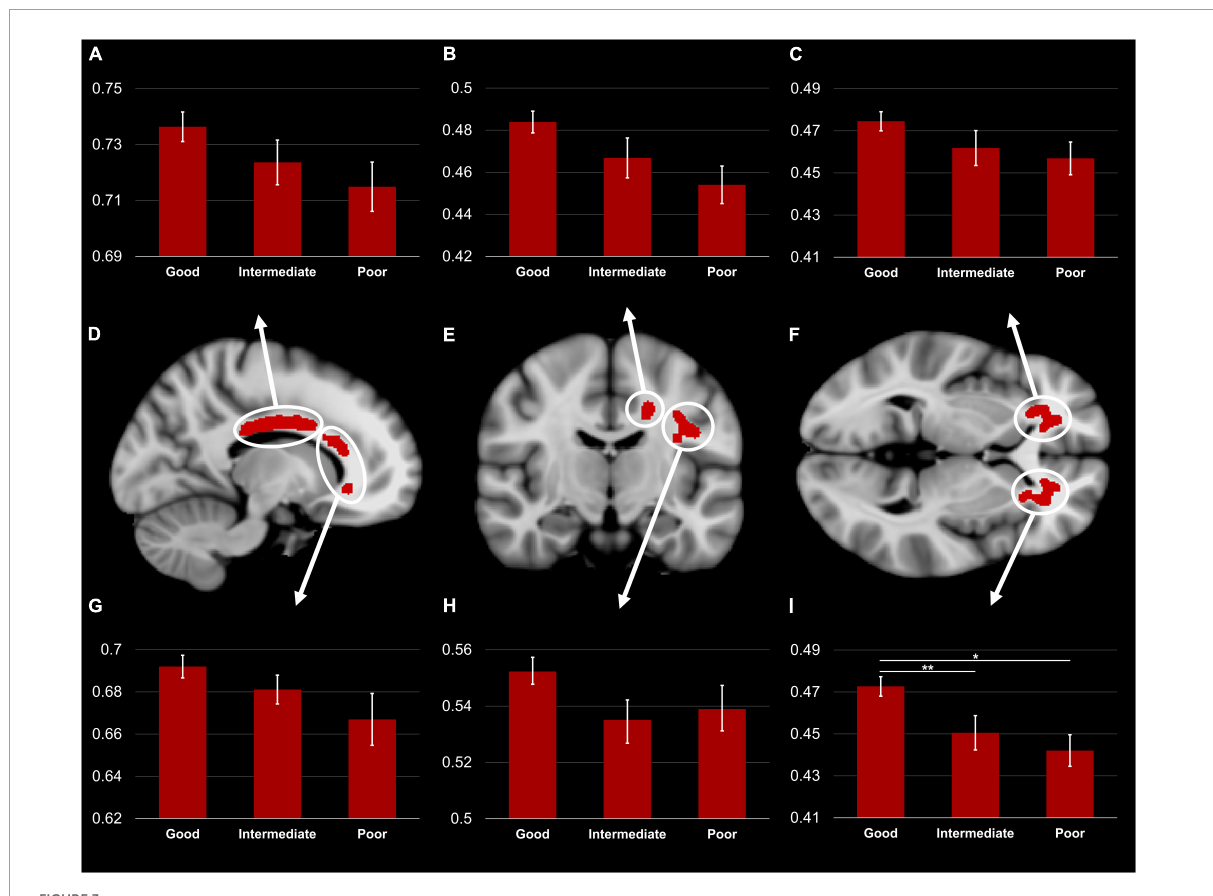
FIGURE3 TBSS Clusters with a significant correlation between DTC of gait speed while subtracting and FA (D–F) displayed on T1 MNI-152 template (1 mm). Group comparison of FA in body (A) and genu (G) of the corpus callosum, left superior corona radiata (B) , left superior longitudinal fasciculus (H) , right (C) and left (I) anterior corona radiata. Error bars represent standard error of the mean. TBSS, tract-based spatial statistics; FA, fractional anisotropy; DTC, dual-task costs. *Significant difference between the good and poor TMT groups ( p < 0.01). **Significant difference between the good and intermediate TMT groups ( p <